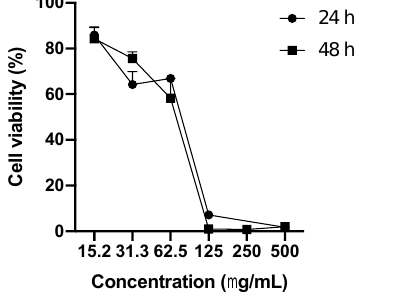
Figure 3. Profile of 5-FU cytotoxicity on WiDr cells by MTT method. WiDr cells were plated on 96 well- plates then treated with 5-FU at concentration 31.3, 62.5, 125, 250, 500, 1000µg/mL for incubation 24 and 48h. Cytotoxicity was expressed by % cell viability shown as mean ±